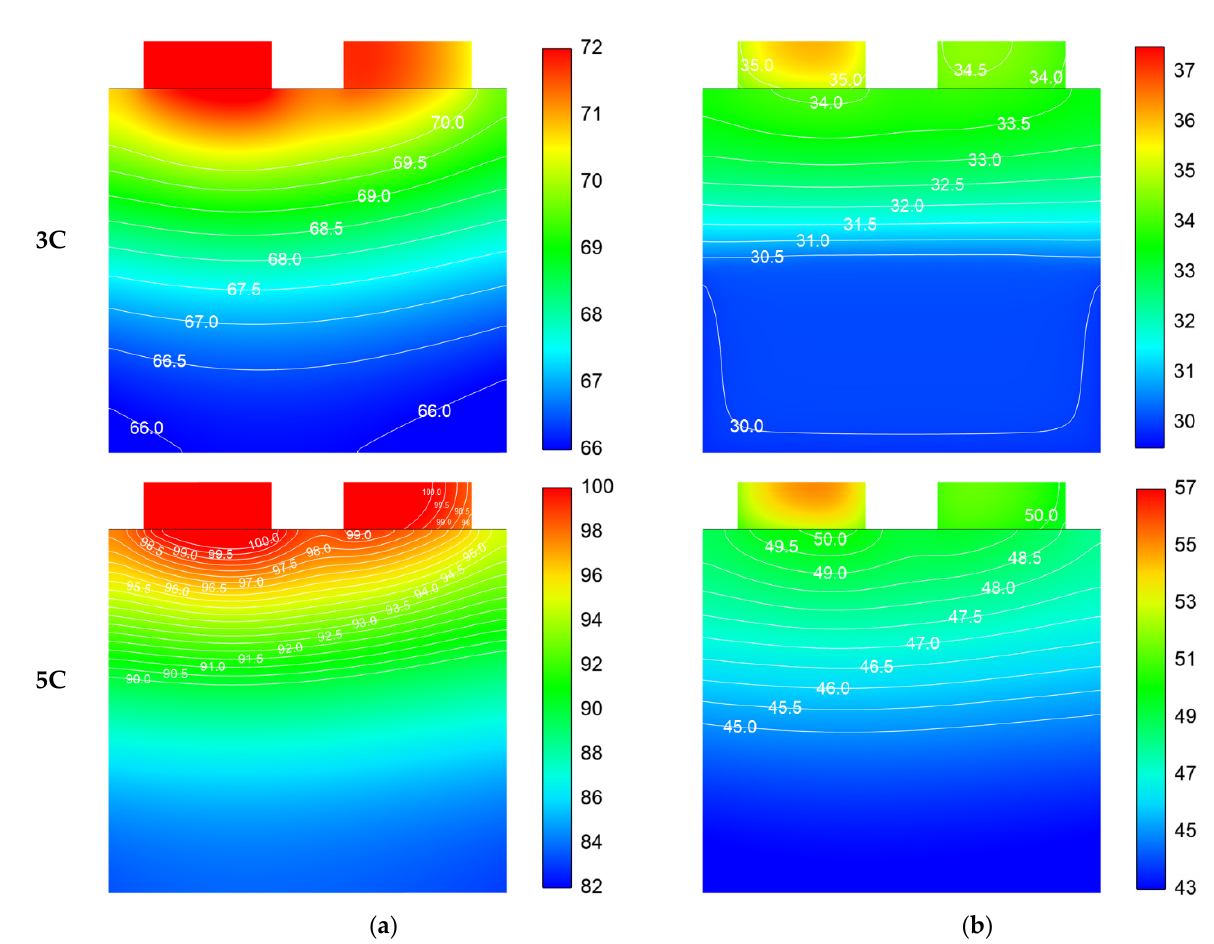
Figure 16. Contour of temperature on battery surfaces (°C) at the end of discharging: ( a ) without PCM; ( b ) with PCM.